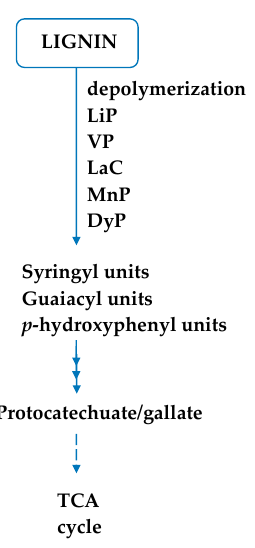
Figure 3. Microbial lignin degradation.